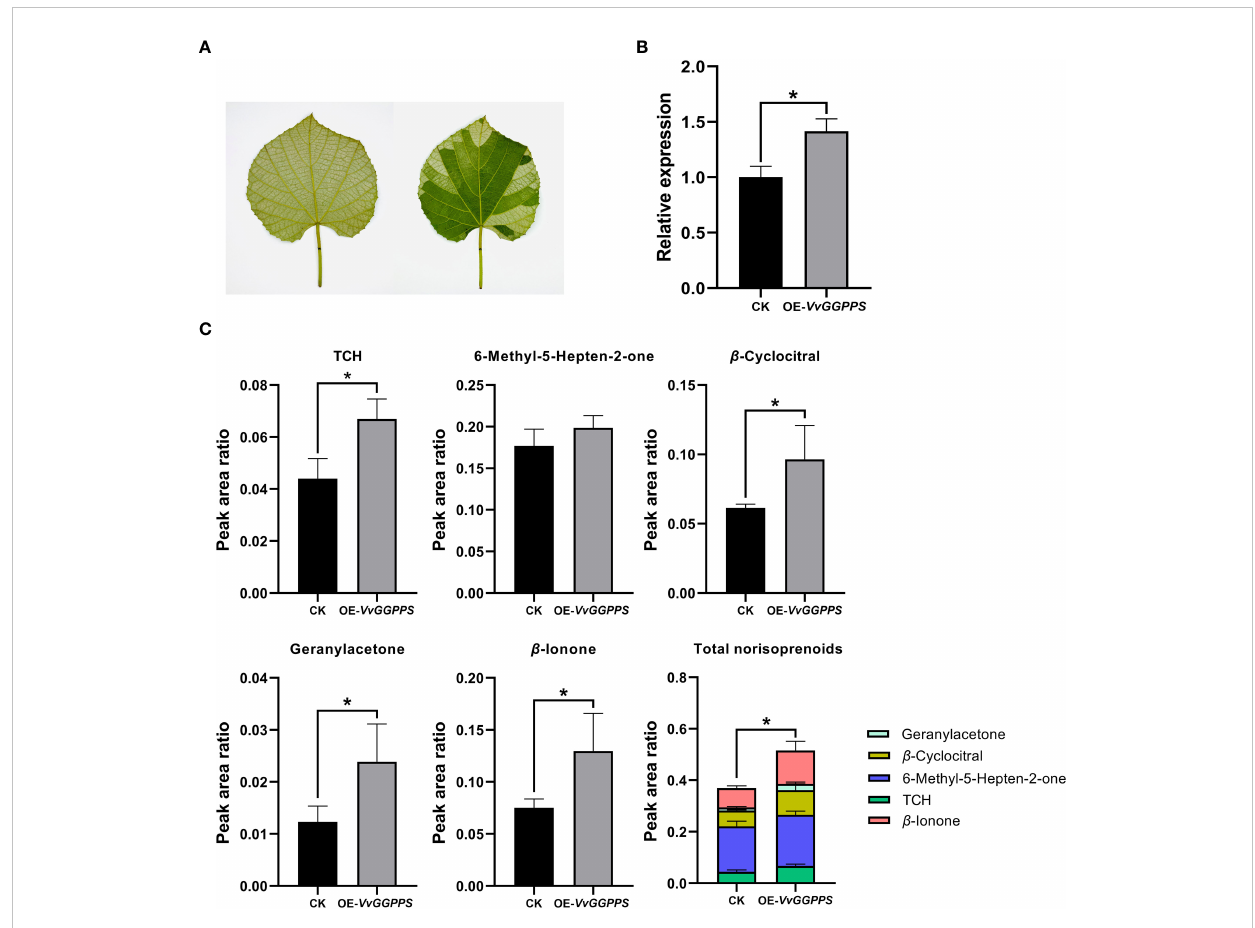
FIGURE 6 Functional analysis of VvGGPPS in the leaves of Vitis quinquangularis . (A) Pictures displaying uninfected (left) and infected (right) leaves of V. quinquangularis. (B) qRT – PCR analysis of VvGGPPS expression in the leaves of V. quinquangularis. ; Ubquintin was used as the internal control. (C) Concentrations of norisoprenoid compounds detected in leaves of V. quinquangularis . CK represents the control groups from uninfected leaves; OE- VvGGPPS represents the overexpressed VvGGPPS groups from infected leaves. The asterisks * indicates signi fi cant levels at p